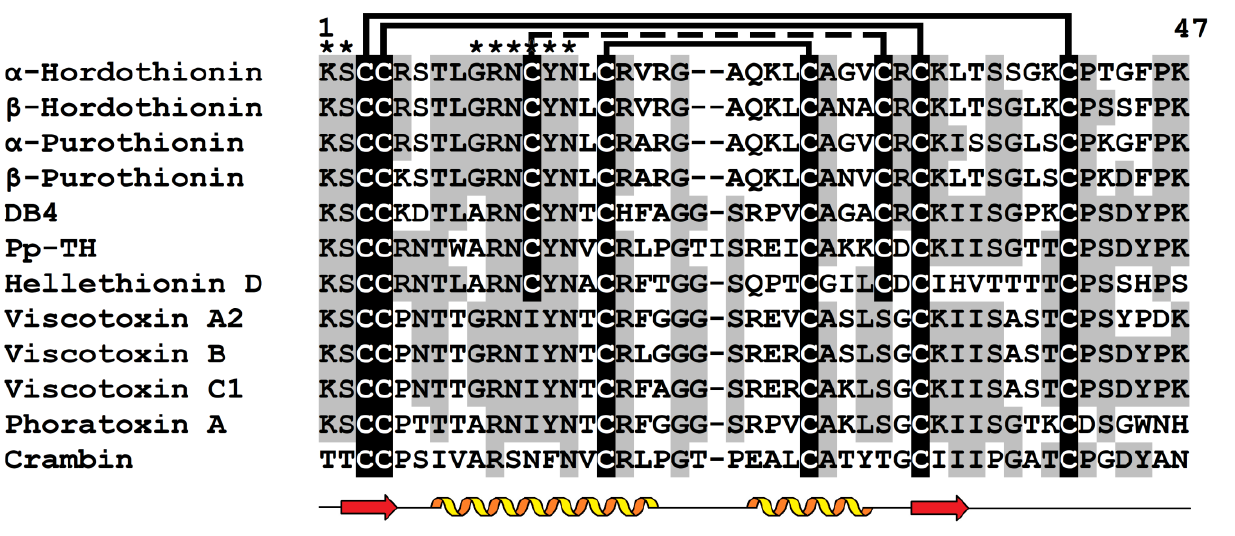
Figure 1. Multiple sequence alignment of selected thionins: α -hordothionin (GenBank AAA32966.1) and β -hordothionin (GenBank 1206255A) from Hordeum vulgare ; α -purothionin (GenBank CAA65313.1) and β -purothionin (GenBank CAA65312.1) from Triticum aestivum , leaf-specific thionin DB4 from H. vulgare (UniProt P08772.2); Pp-TH from Pyrularia pubera (UniProt P07504.1); hellethionin D from Helleborus purpurascens (UniProt P60057.1); viscotoxin A2 (UniProt P32880.1), B (GenBank P08943.2), and C1 (UniProt P83554.1) from Viscum album ; phoratoxin A from California mistletoe (UniProt P01539.1); crambin from Crambe abyssinica (UniProt P01542.2). Cysteine residues are highlighted in white on the black background. Conserved amino acid residues are highlighted in black on the grey background. Lines above the sequences denote disulfide bonds. Asterisks indicate conserved amino acid residues supposed to be involved in interactions with phospholipids. Secondary structure elements (α - heliсеs and β - strands) for β -purothionin (PDB 1BHP) are shown under the alignment as helices and arrows, respectively.